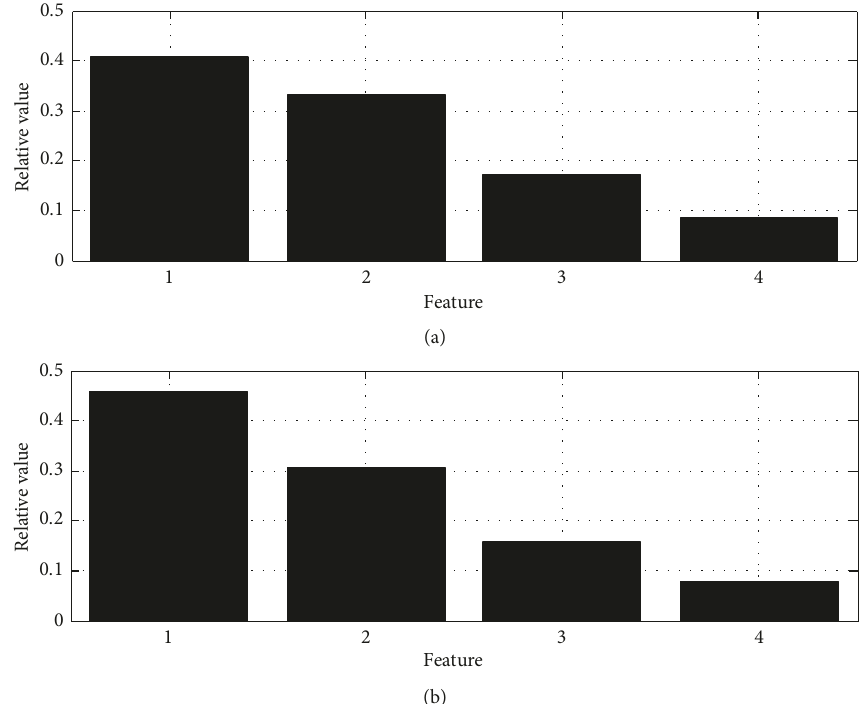
Figure 3: The features of two samples representing outer race fault and ball fault, respectively, in a set of samples based on LWT-SVD. (a) The features of the sample representing outer race fault, and (b) the features of the sample representing ball